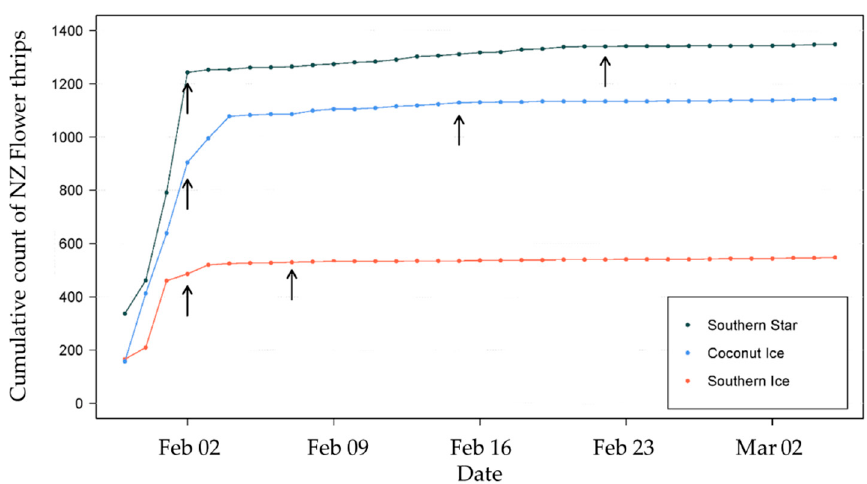
Figure 4. Effect of insecticides in three blocks with different varieties of peaches, on daily cumulative catch of Thrips obscuratus monitored by camera traps. Arrows indicate insecticide applications, which were timed to reduce incidence before harvest commenced.